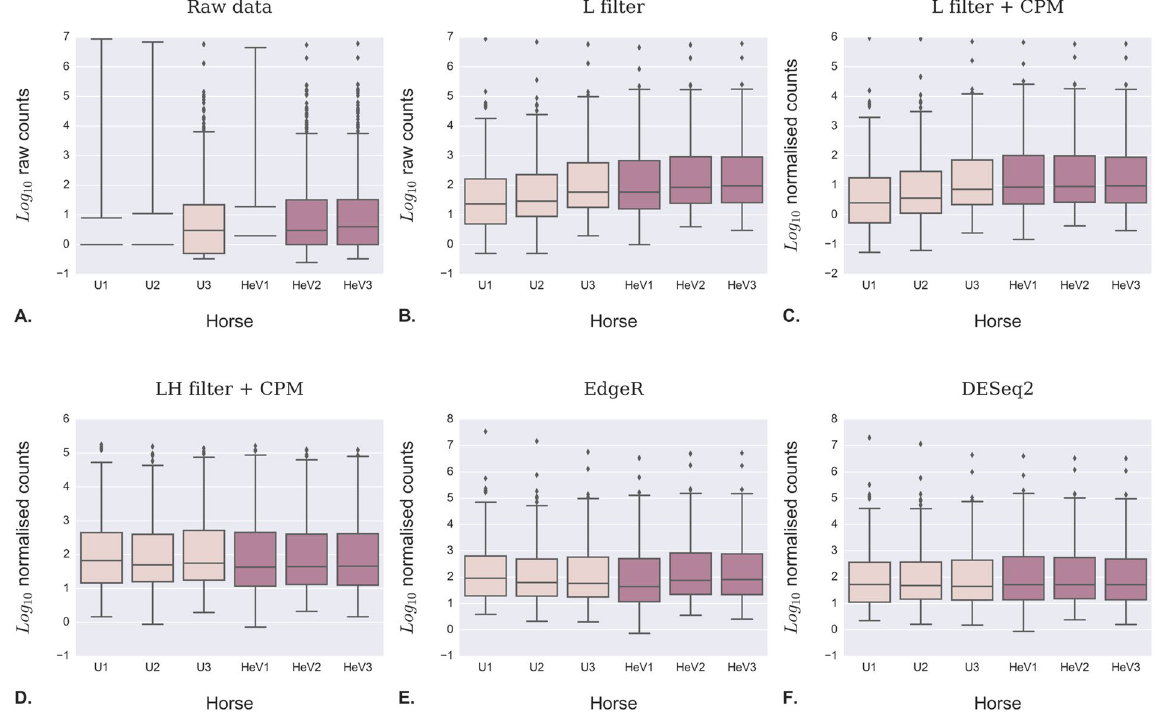
Figure 3. The impact of different data normalization strategies on miRNA profiles. Boxplots illustrate the impact of various normalization strategies on inter-sample variance. The midline of each box is the median value (50 th percentile), the upper and lower bounds of the box represent the interquartile range (25 th to 75 th percentiles), while the whiskers represent 1.5x the interquartile range. Values outside this range are considered outliers and are plotted individually as dots. Data are plotted on a log 10 scale. Distributions are shown for raw reads ( A , raw data), raw reads excluding low read counts ( B , L filter), data as in ( B ) normalized for counts per million ( C , L filter + CPM), data as in ( B ) excluding both low and high read counts ( D , LH filter + CPM), ( E ) data as in ( B ) analyzed by EdgeR, ( F ) data as in ( B ) analyzed by DESeq2. * Note regarding Fig. 3A (raw data): A large number of miRNAs with low abundance are still present within the raw data including many that were not detected in all six samples. Consequently, the 25 th percentiles for U1, U2, and HeV1 were equal to zero, causing the boxplot drawing algorithm to fail. Removal of low-abundance miRNAs resolved the problem (3 B – F ).